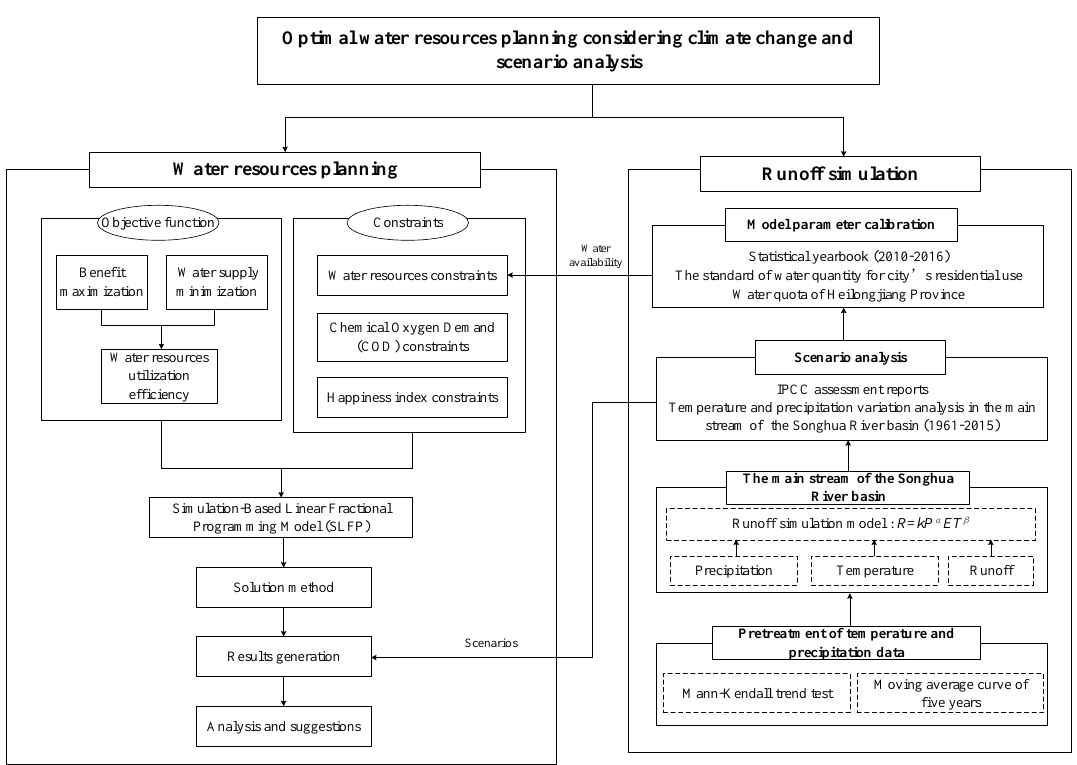
Figure 2. Decision procedure of the developed framework for water resource planning.